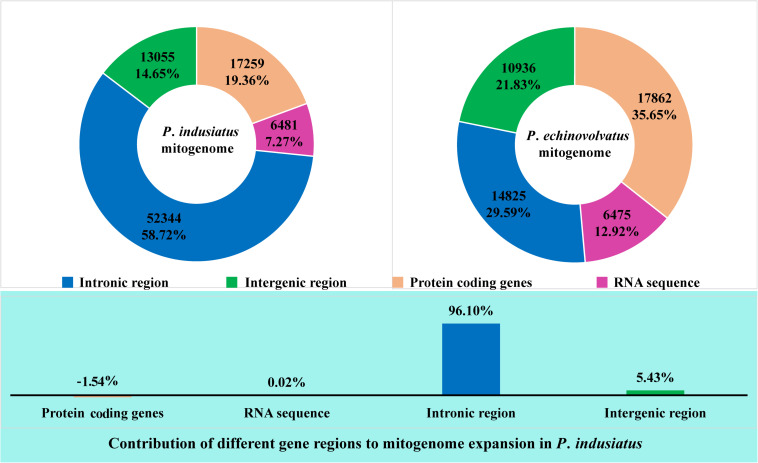
The intronic, intergenic, protein-coding, and RNA gene region proportions of the entire mitogenomes of two Phallus species. The bottom panel shows the contribution of different gene regions to the expansion of the P. indusiatus mitogenome. The value of bar chart is based on the ratio of differences in the protein-coding genes, RNA sequence, intronic region, and intergenic region between P. indusiatus and P. echinovolvatus mitogenomes to the difference of their entire mitogenomes.